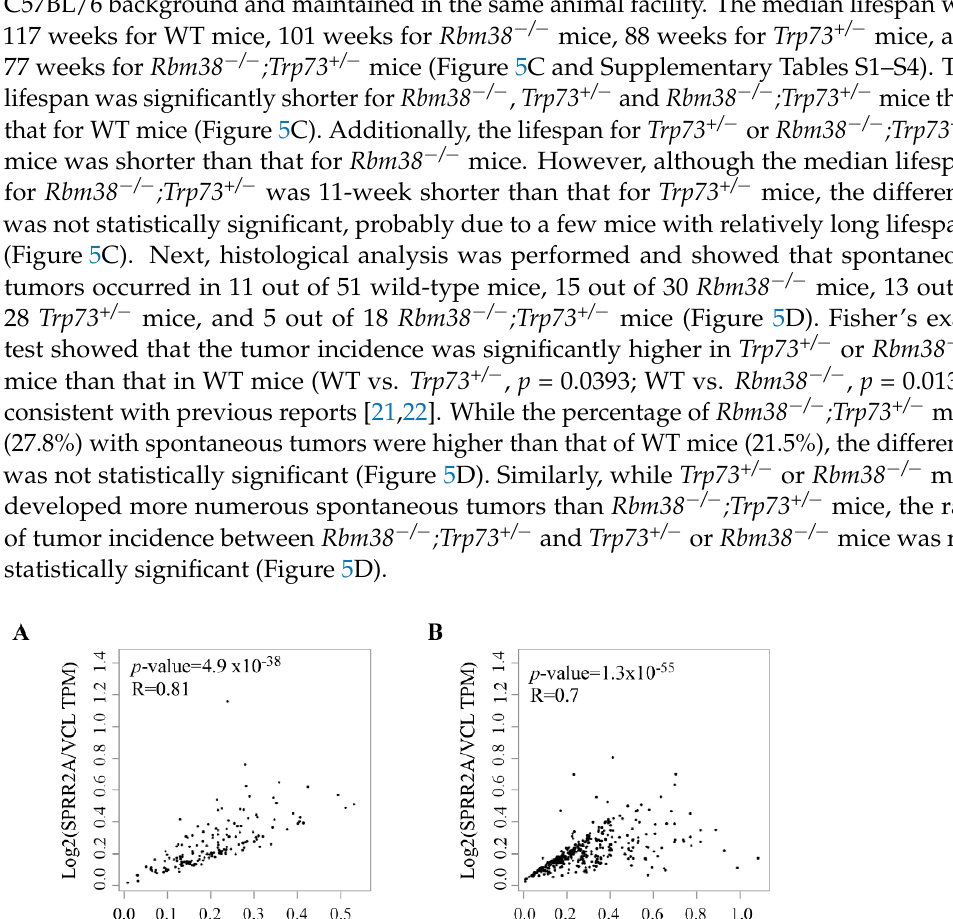
Figure 3. SPRR2A and SPRR2D are induced by p73 and RBM38 to promote keratinocyte differenti ‐